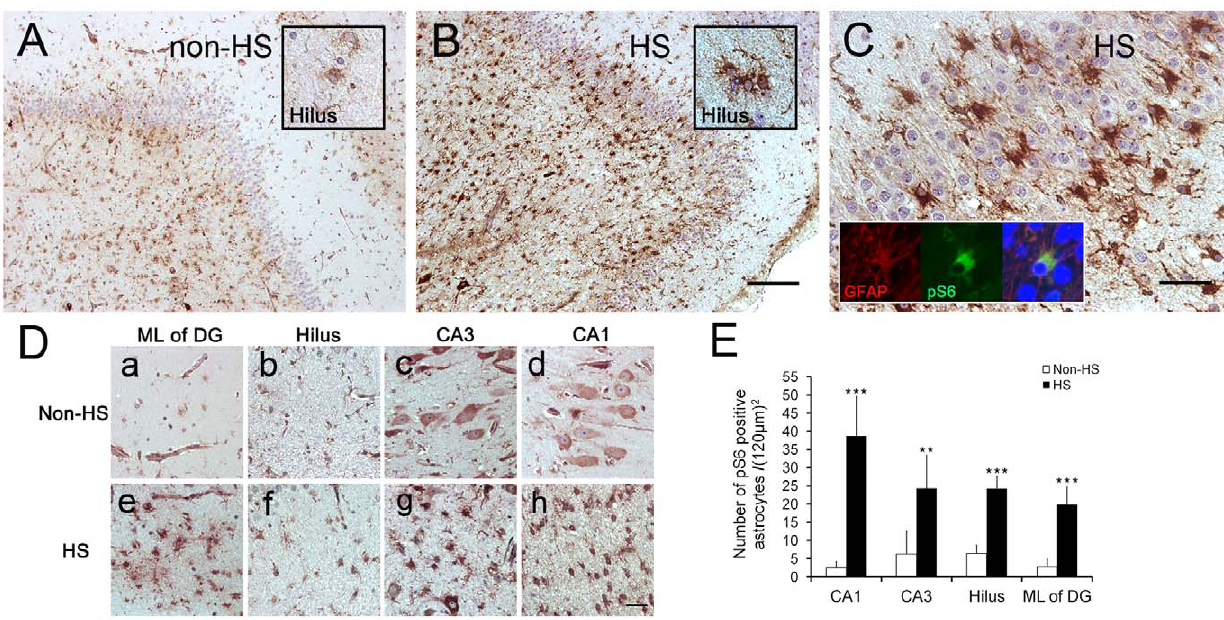
Figure 4. mTOR activation in the granule cells of the sclerotic hippocampus is associated with neuronal hypertrophy. In the dentate gyrus of non-sclerotic hippocampus, granule cells have uniformly sized cell bodies and pS6 expression is below detection level (A). In the sclerotic hippocampus, pS6-positive and negative granule cells are different sizes (B, red and black two-headed arrows indicate pS6 negative and positive neurons, respectively). pS6 positive granule cells in the dentate gyrus have larger cell bodies than do pS6-negative cells (F). A special non-sclerotic hippocampus with recently emerging seizures induced by a glioma also exhibits some granule cells with substantially increased pS6 expression (C), but both pS6-positive and -negative cells have the same cell size (F). KA mice at 2 weeks post-SE were used to study the cell size of pS6 positive and negative neurons, both upper (D) and lower blades (E) of DG were involved in the statistic analysis (F). Error bars are means 6 SD., **p , 0.01 is based on Student’s t-test. Scale bar in A-C: 50 m m; in D-E: 25 m